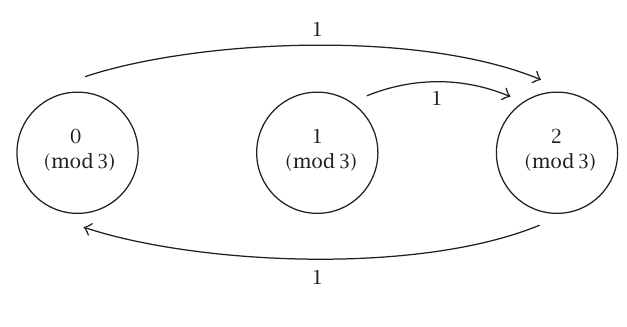
Figure 4.2 . Extreme game B .